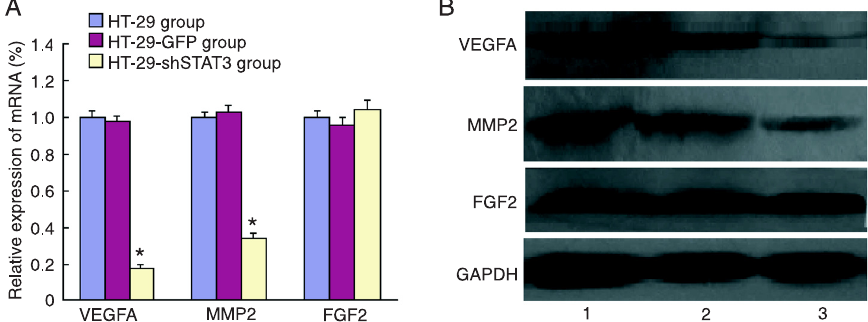
Figure 6. A , VEGFA, MMP2 and FGF2 mRNA expression of each group. Data are reported as means ± SEM (N = 5). *P < 0.05, significantly different from the other two groups (ANOVA). B , Expression of VEGFA, MMP2 and FGF2 proteins (an example of a mouse tumor sample from each group). Lane 1 = HT-29 group; lane 2 = HT-29-GFP group; lane 3 = HT-29-shSTAT3